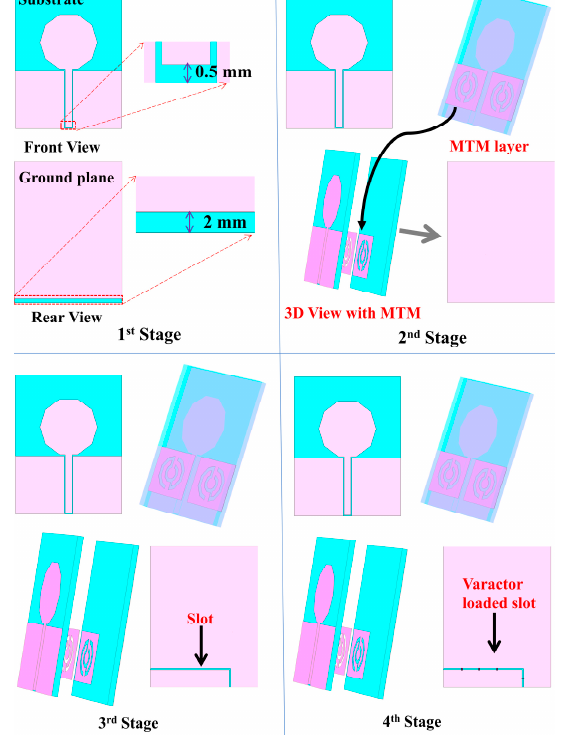
Figure 4. Evolution process of the MBRU antenna in this study.